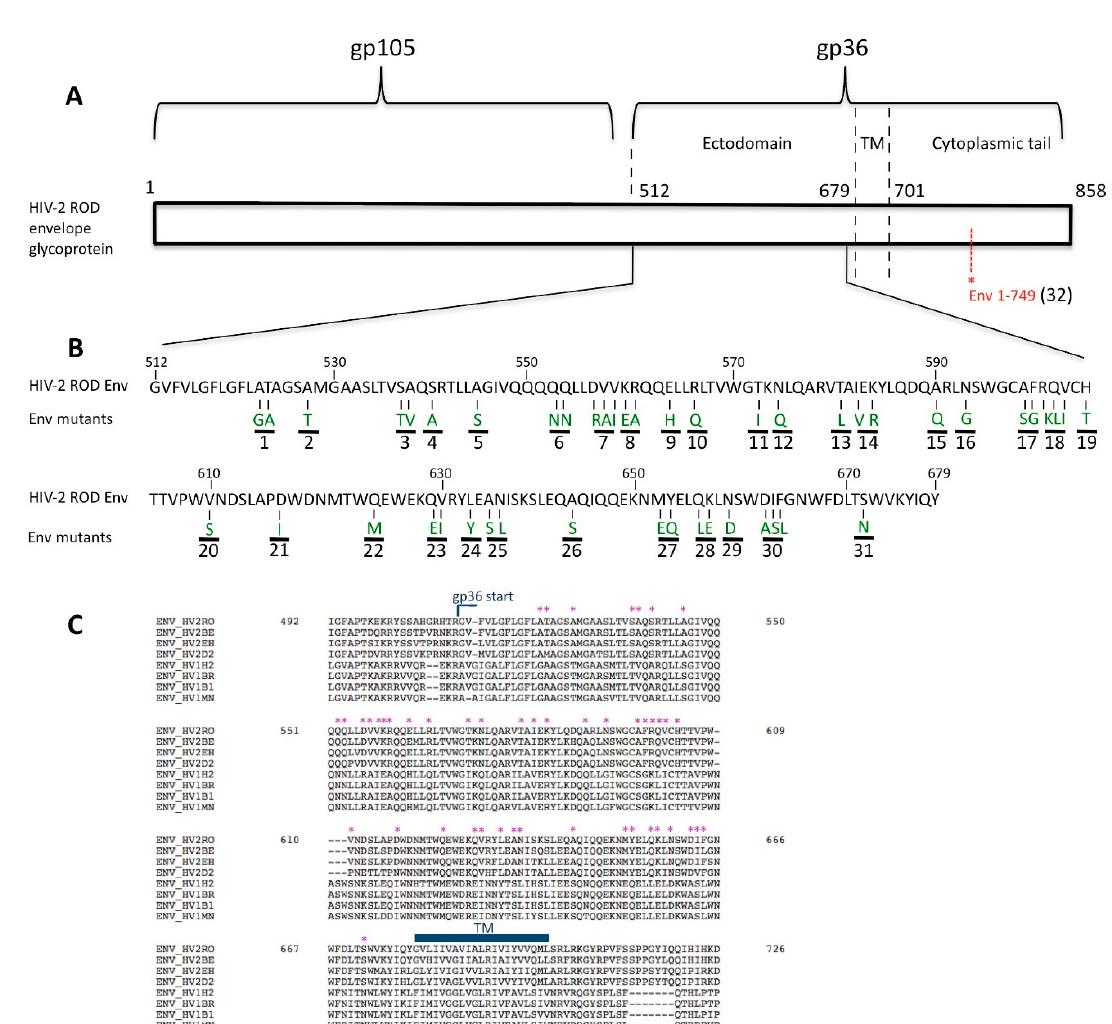
Figure 1. Schematic representation of human immunodeficiency virus type 2 (HIV-2) ROD envelope glycoprotein (Env). ( A ) The functional HIV-2 ROD Env protein is composed of an external domain (gp105) and a transmembrane domain (gp36). Three regions comprise gp36: the ectodomain, the membrane spanning domain and the cytoplasmic tail (158 amino acids). To generate a mutant virus with a truncated cytoplasmic tail (Env 1–749), the tryptophan residue (TGG) at the env position 749 was replaced with a stop codon (TAA) using site-directed mutagenesis. This position is indicated in red in this figure (TM: transmembrane domain); ( B ) Amino acids 512 to 679 composing the HIV-2 ROD gp36 ectodomain are shown in this panel. Based on a comparison of the HIV-1 and HIV-2 gp41/36 amino acid sequences, 47 positions were selected (Env mutants). All the selected amino acids mutations are highlighted in green, each corresponding to the related HIV-1 Env residues used to generate substitutions by side-directed mutagenesis of the pKP59 HIV-2 ROD plasmid. The 32 HIV-2 Env mutants generated in this study are numbered and highlighted with the black lines in this figure; ( C ) Alignment and comparison of the HIV-1 and HIV-2 gp41/36 amino acid sequences. Selected amino acids are pointed with the symbol * (Env_HV2RO: HIV-2 ROD strain; Env_HV2BE: HIV-2 BEN strain; Env_HV2EH: HIV-2 EHO strain; Env_HV2D2: HIV-2 D205 strain; Env_HV1H2: HIV-1 HXB2 strain; Env_HV1BR: HIV-1 BRU/LAI strain; Env_HV1B1: HIV-1 BH10 strain and Env_HV1MN: HIV-1 MN strain).